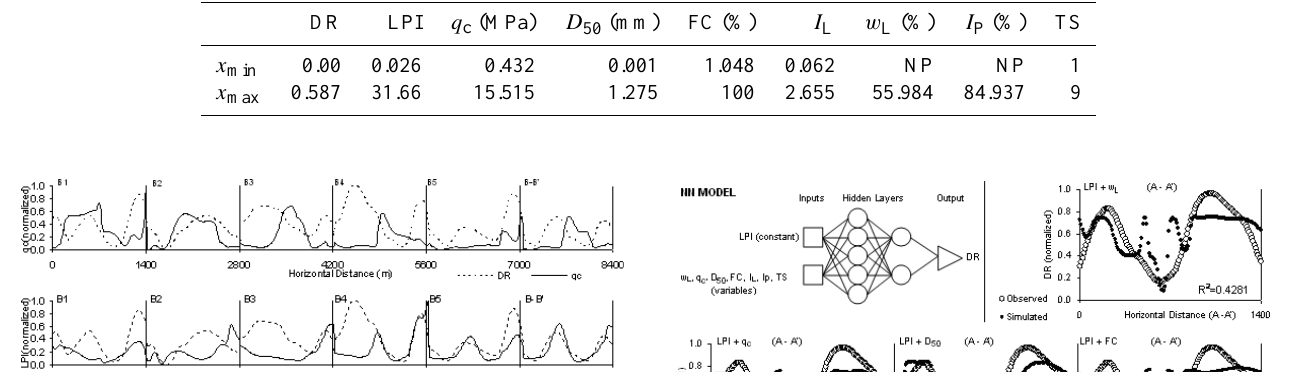
Table 4. The maximum and the minimum values in the thematic maps.